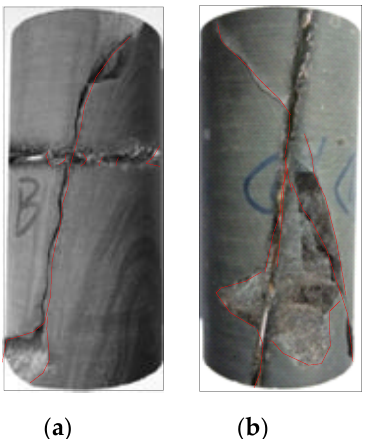
Figure 16. Damage patterns of consolidated siltstone mass specimens. ( a ) Horizontal consolidation and ( b ) vertical consolidation.